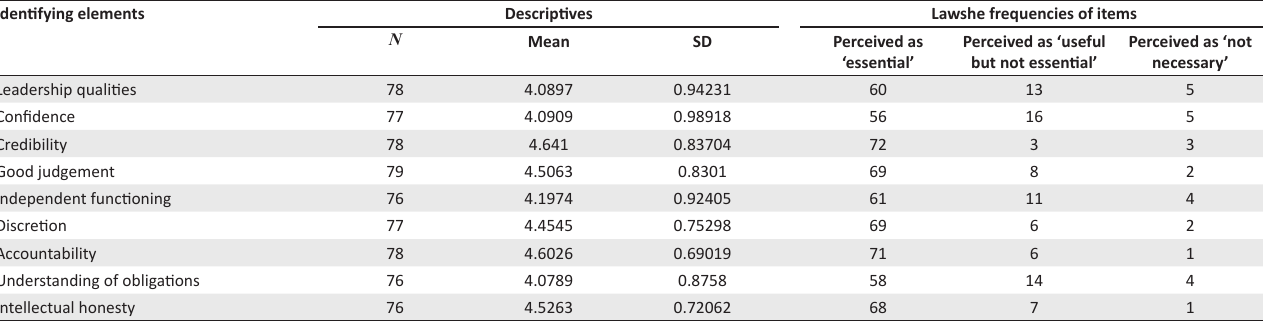
TABLE 5: Descriptive statistics of desirable professional qualities. Identifying elements